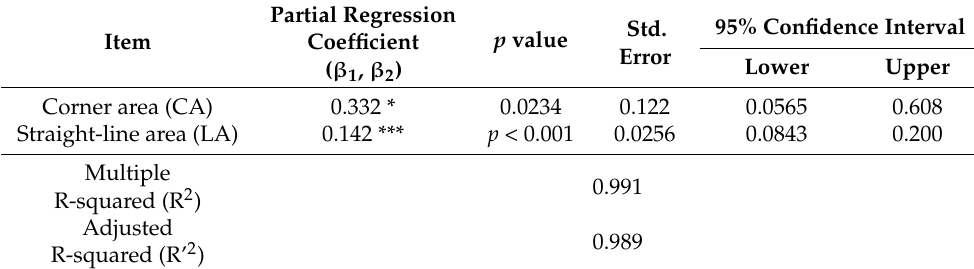
Table 11. Multiple regression analysis results using progressive crushing mode results. (MCF).